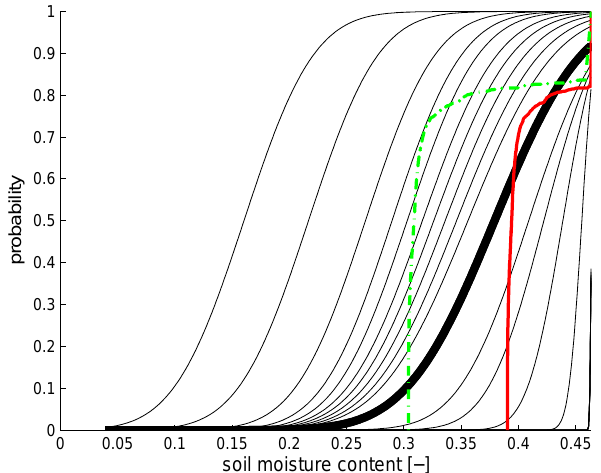
Fig. 8. Modelled empirical cdf (green dashed line) and its optimisation (red solid line) according to the information present in the bundle (cumulative normal distributions originating from the endpoints of the possibility distribution are given in black solid lines).